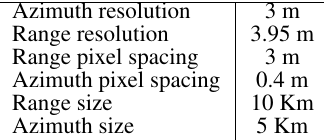
Table 2. Main processing settings for the considered focused SARAT images.